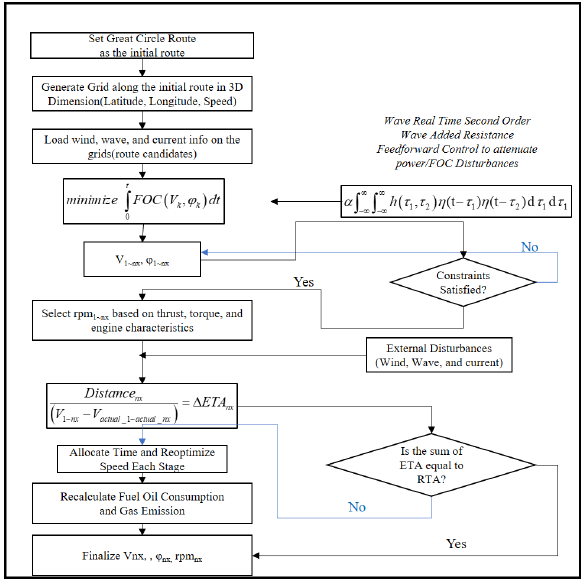
Figure 12. Wave feed forward control algorithm.